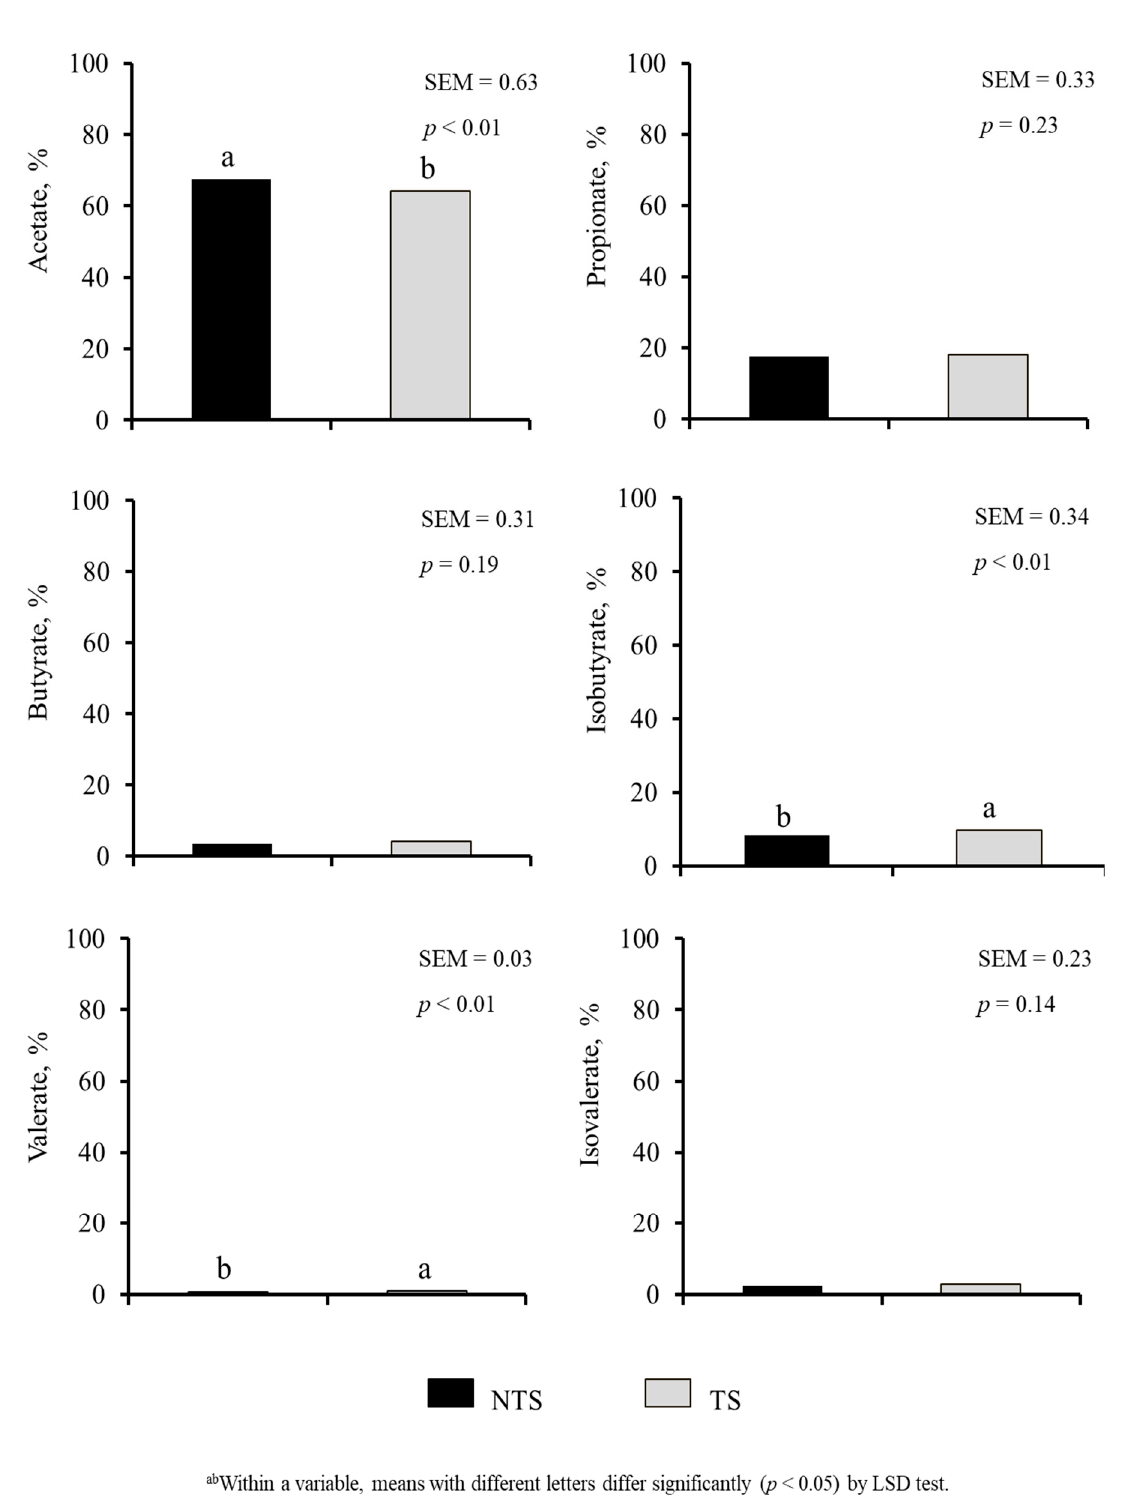
Figure 7. Effects of Stress Treatment (ST; NTS: non-transported; TS: transported) on rumen volatile fatty acid composition. Acetate, isobutyrate and valerate concentrations were significantly influenced by ST ( p < 0.01).